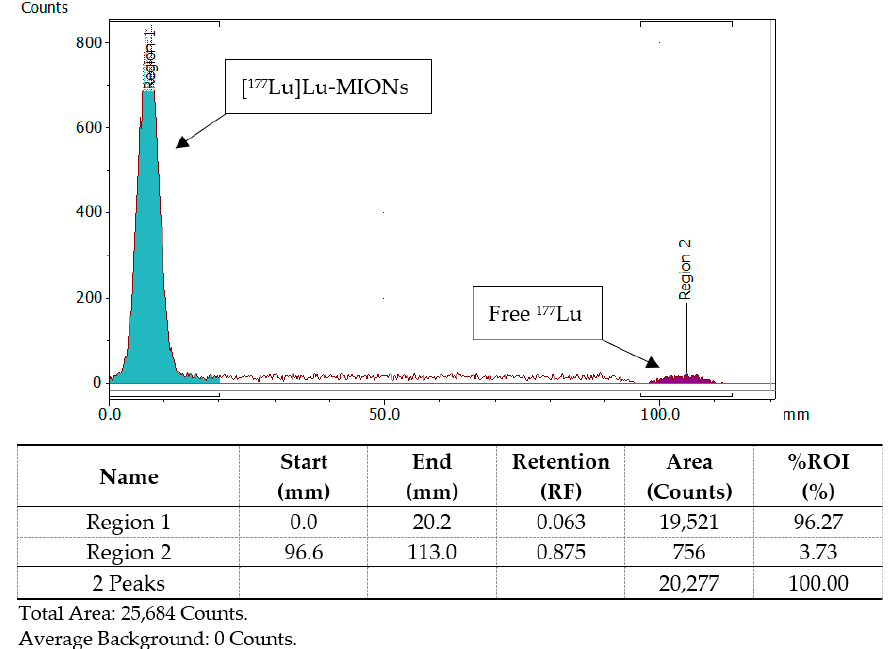
Figure 5. Representative radio-TLC chromatograph of [ 177 Lu]Lu-MA or [ 177 Lu]Lu-MAPEG after 30 min of incubation at 75 °C.